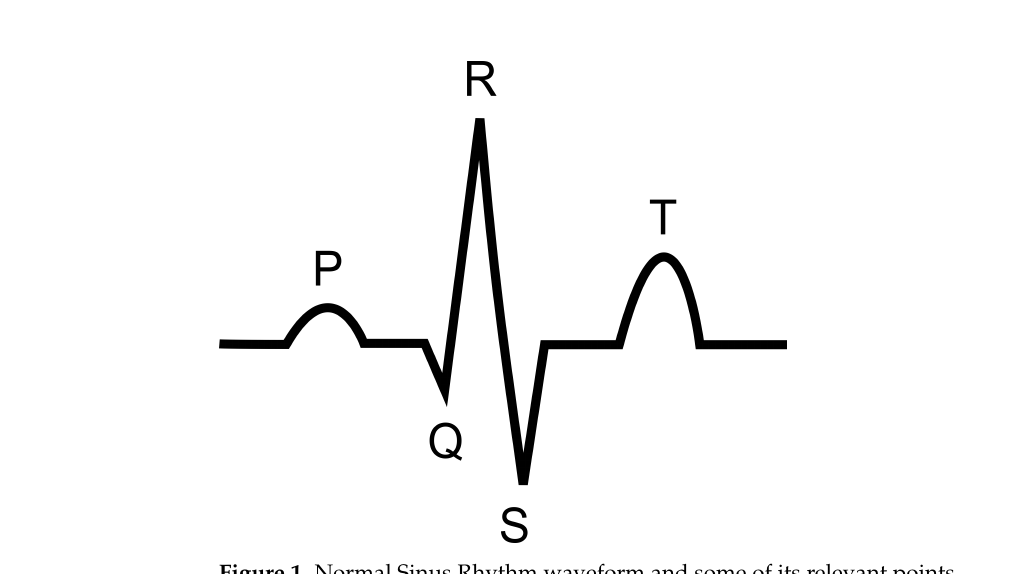
Figure 1. Normal Sinus Rhythm waveform and some of its relevant